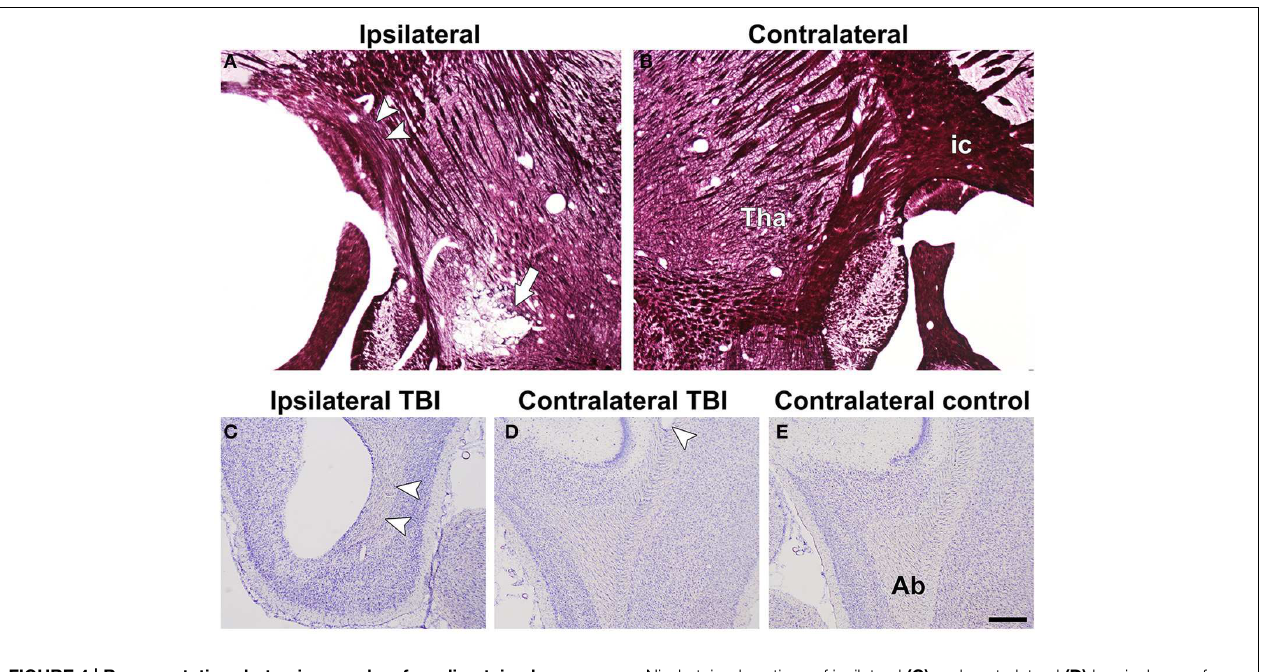
FIGURE 4 | Representative photomicrographs of myelin-stained sections of the ipsilateral (A) and contralateral (B) hemispheres of a TBI animal from the in vivo group. Arrowheads point at the loss of myelinated axons in the internal capsule. The white arrow indicates calcifications in the thalamus. Representative photomicrographs of